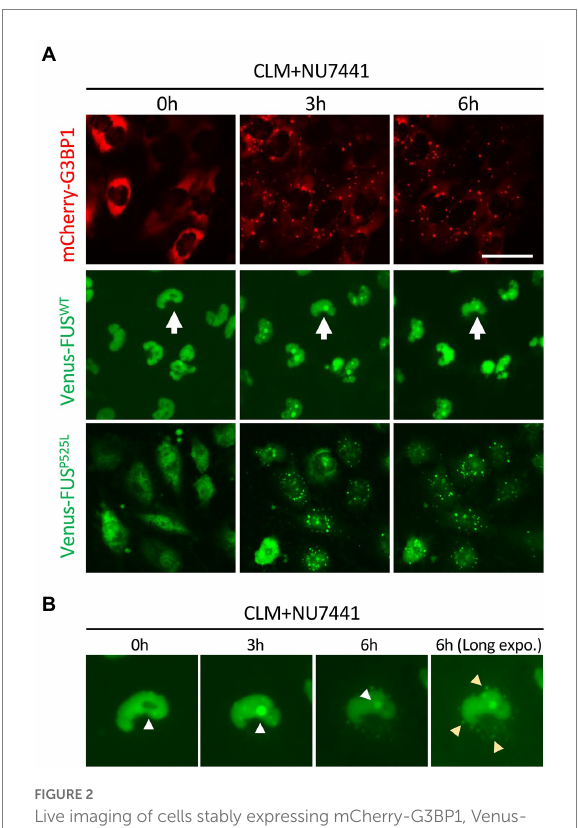
FIGURE 2 Live imaging of cells stably expressing mCherry-G3BP1, Venus- FUS WT, and Venus-FUS P525L . (A) Cells were treated with 1 μ M NU7441 for 3 h and were then treated with 100 nM CLM for 0, 3, and 6 h in the presence of 1 μ M NU7441. To visualize cytosolic SGs, U251 MG (KO) cells overexpressing mCherry-G3BP1 were generated and treated with 100 nM CLM for 3 and 6 h. Scale bar: 50 μ m. (B) The cells with white arrows in the images are shown at high magnification. The yellow arrowheads indicate SGs in the long-exposure